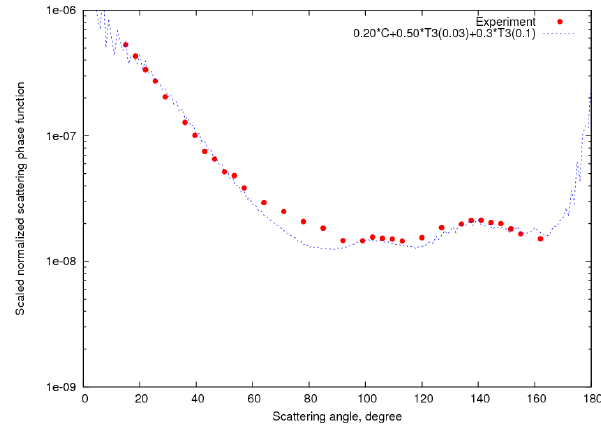
Fig. 8. Same as Fig. 7, but for weighted habit mixture model 3, 0.2*C+0.5*T3 (0.03) + 0.3*T3 (0.1). 799